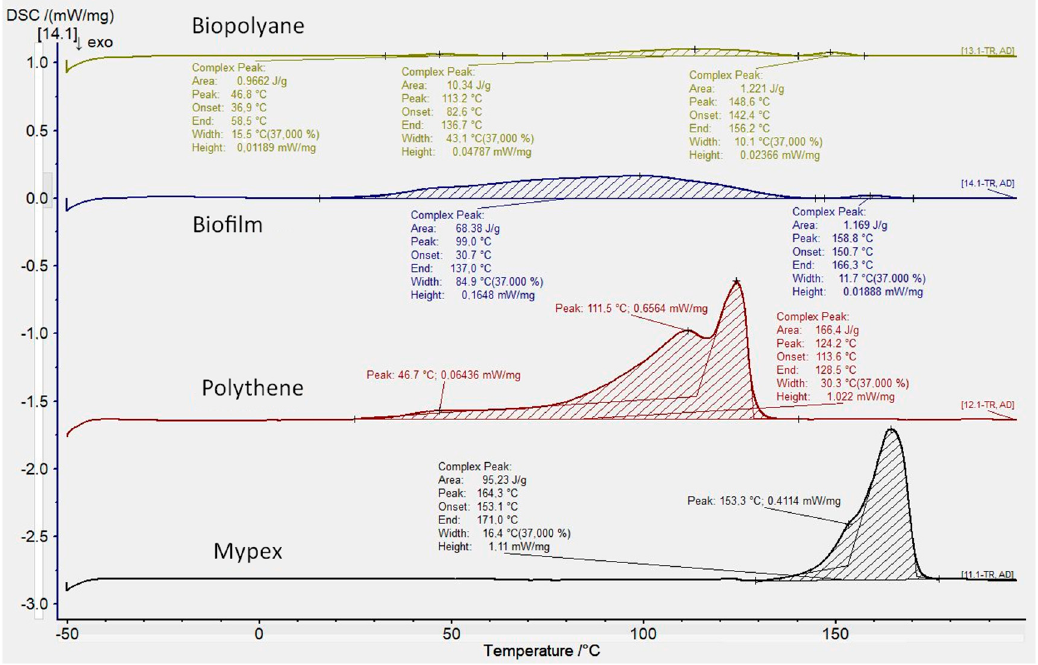
Figure 5. DSC thermograms obtained for samples of conventional and commercial biodegradable